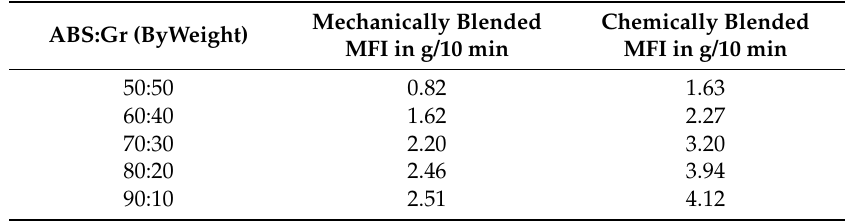
Table 1. Melt flow index (MFI) of acrylonitrile-butadiene-styrene (ABS) blended with Gr as per ASTM D 1238-73.